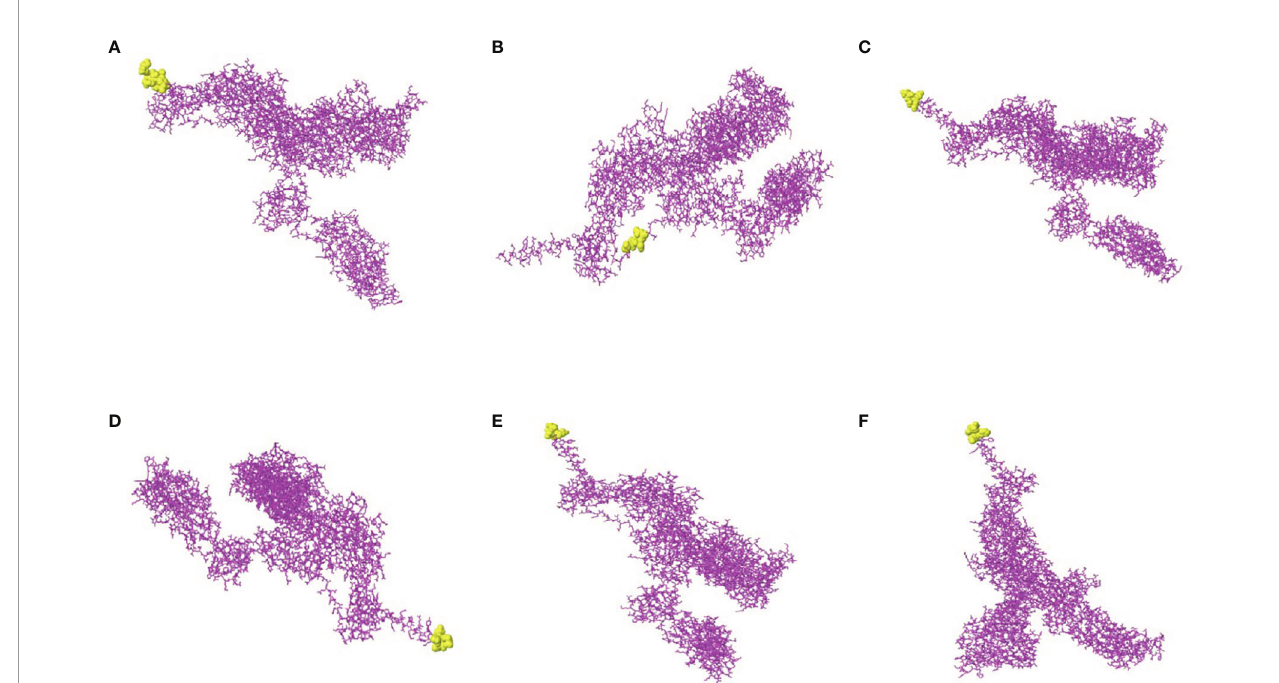
FIGURE 7 | The conformational B-cell epitopes of six SARS-CoV-2 lineages. (A) The “ yellow ” region is the predicted best conformational B-cell epitope of S protein of virus strain Wuhan-Hu-1. (B) The “ yellow ” region is the predicted best conformational B-cell epitope of S protein of virus strain B.1.1.7. (C) The “ yellow ” region is the predicted best conformational B-cell epitope of S protein of virus strain B.1.351. (D) The “ yellow ” region is the predicted best conformational B-cell epitope of S protein of virus strain P.1. (E) The “ yellow ” region is the predicted best conformational B-cell epitope of S protein of virus strain B.1.429. (F) The “ yellow ” region is the